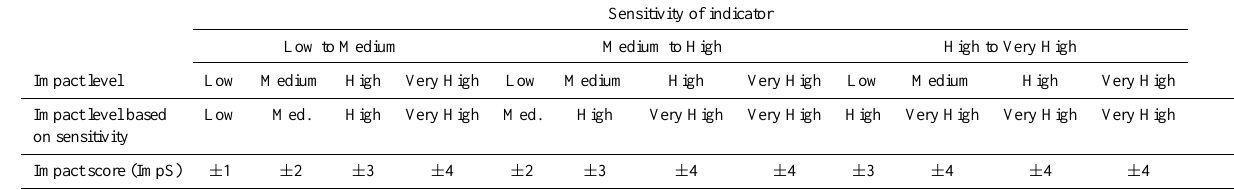
Table 3. A sample of qualitative impacts scoring matrix based on the sensitivity of the indicator.